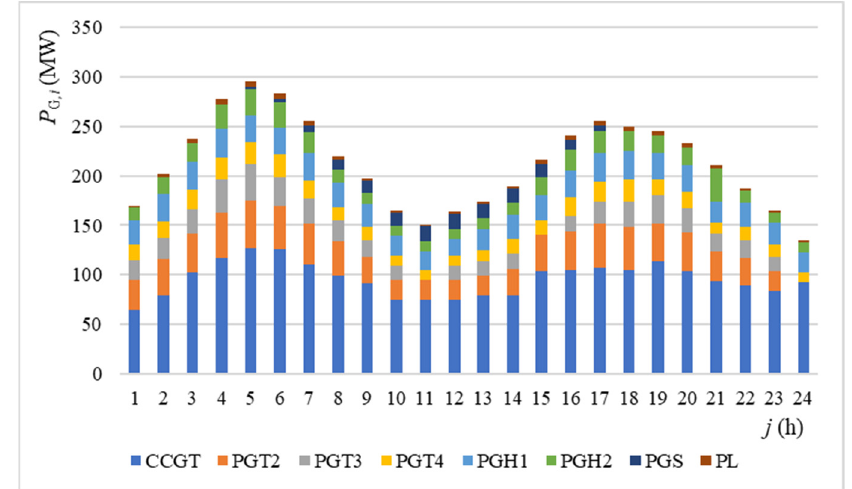
Figure 14. Optimal generation scheduling for case 2–sub-case 3.